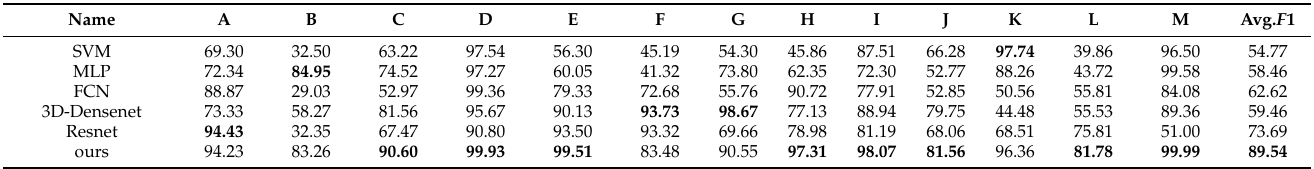
Table 5. Per category results for Area_1. The best results are highlighted in bold.